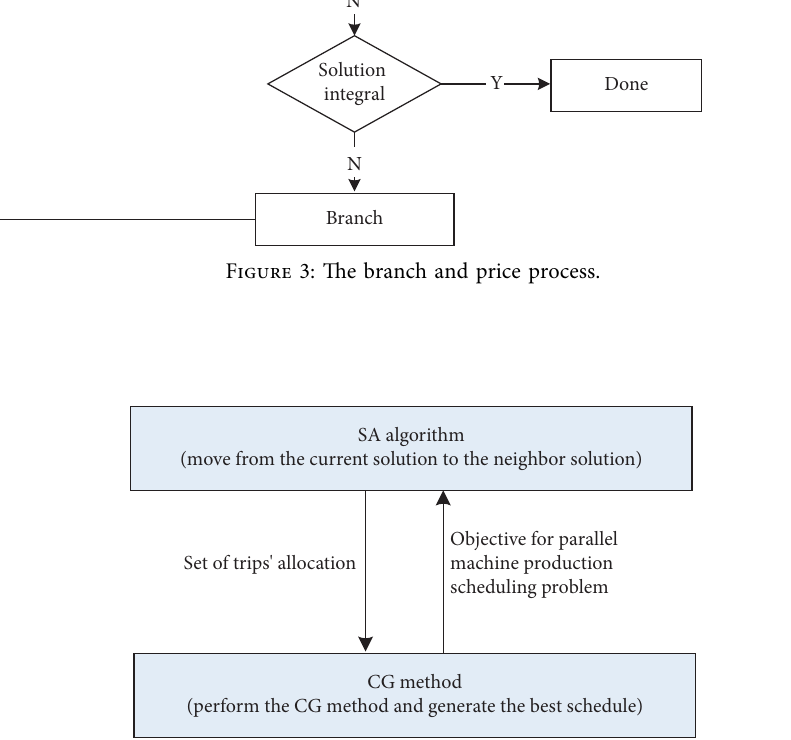
Figure 4: The framework of the developed Two major algorithm parameters related to iteration times are tested here, and the results are shown in Table 4. Different combinations of T and q are used to 0 solve the problem. The results show that when we set a larger initial temperature ( T ) and a larger descent rate 0 ( q ), the optimal result can be improved to a certain � 0 or q � 0, the SACG algorithm cannot extent. When T 0 work.